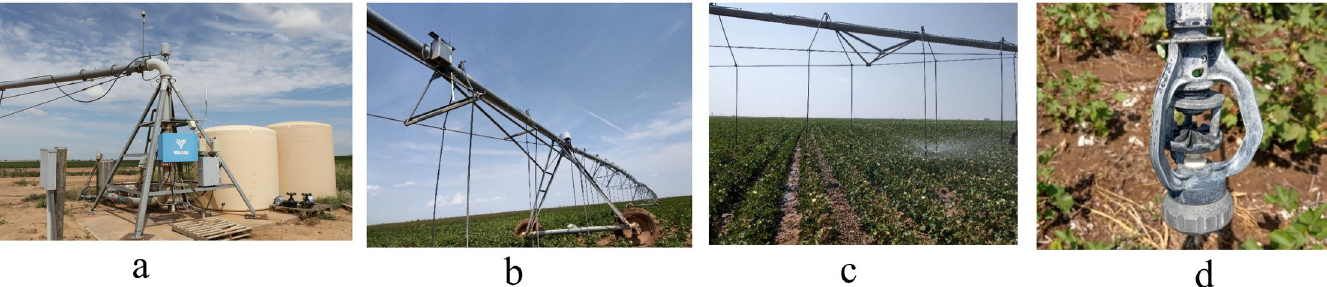
Fig 2. Components of a variable rate irrigation system in a 194-ha farm in Hale County, Texas (a. Control panel, b. Center pivot, c. Variable application of water, and d. Sprinkler head).